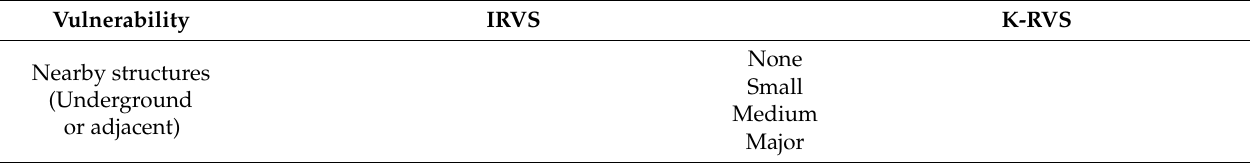
Table 6. Comparison table for vulnerability between IRVS and